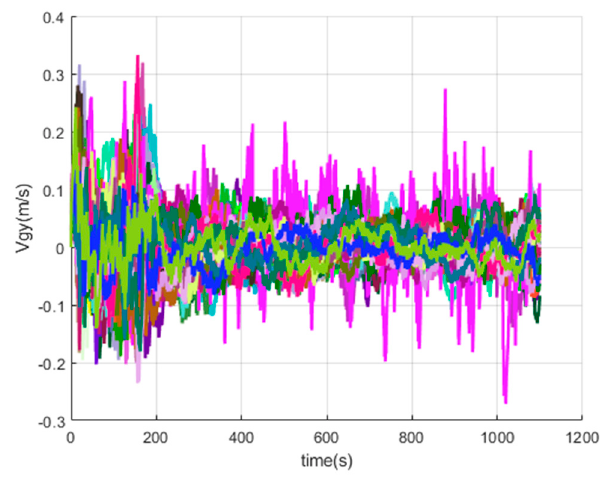
Figure 20. The y -axis velocity errors of SINS / GPS in the LCEF frame.